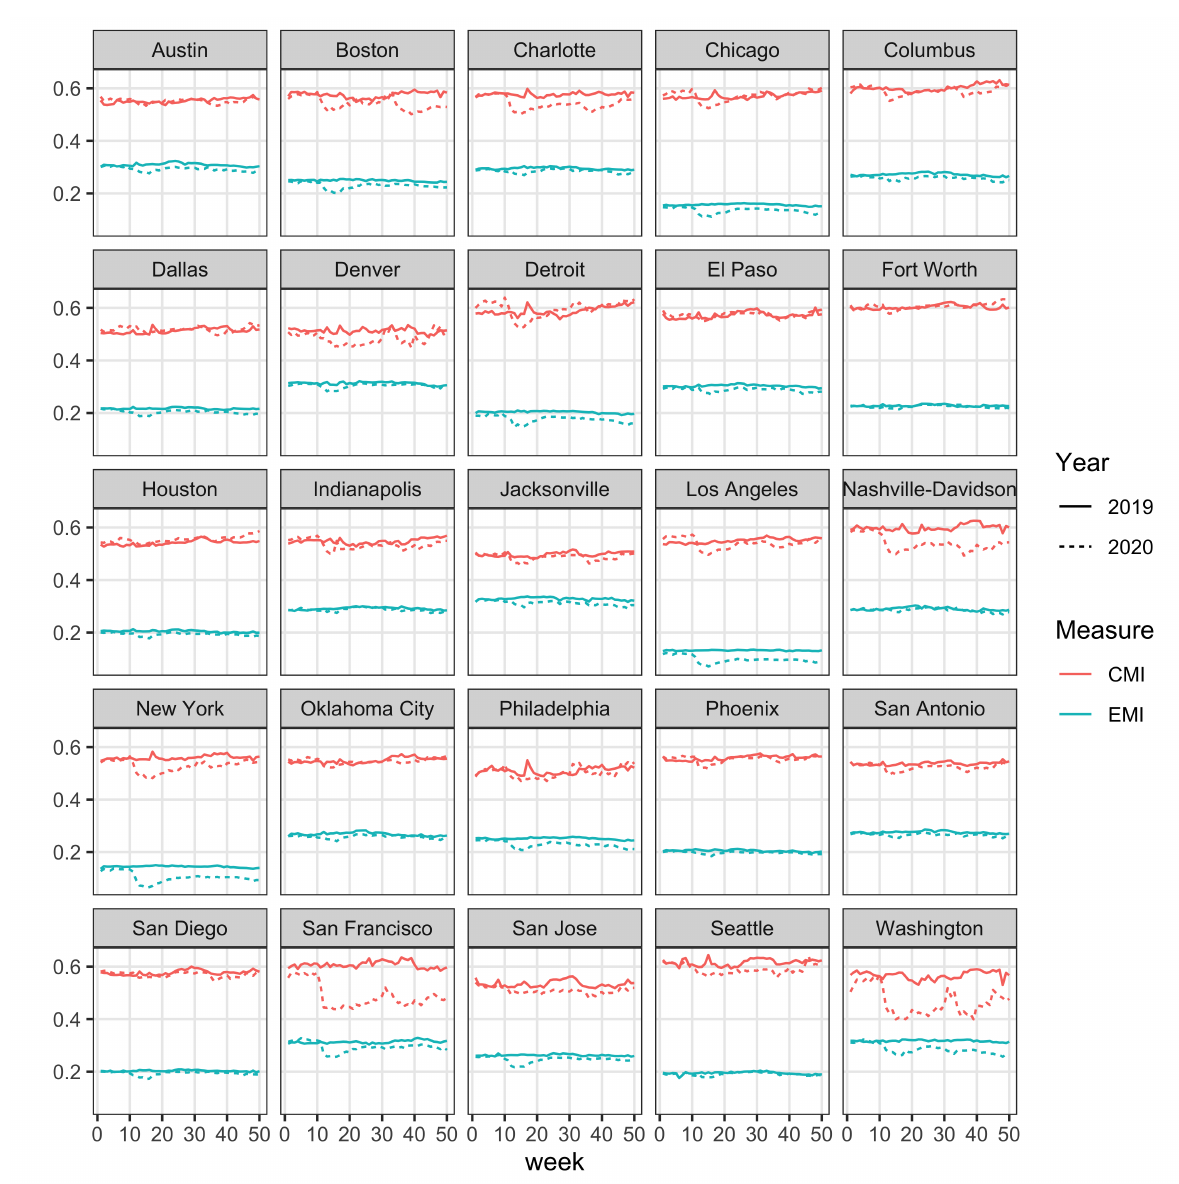
Figure 1: Weekly CMI and EMI values in the 25 largest U.S.